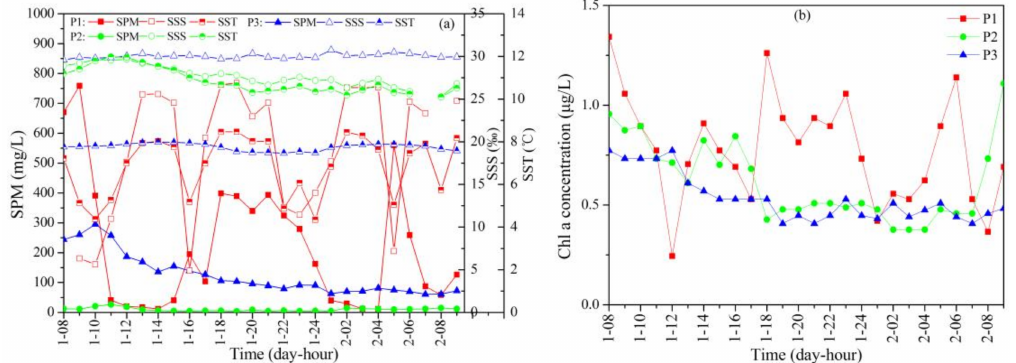
Figure 2. Hourly variations at Stations P1 (red squares, N = 26), P2 (green circles, N = 26) and P3 (blue triangles, N = 26) of: SPM, SSS, and SST ( a ); and Chl-a ( b ). The variation of SSS is consistent with that of SST which can be used as an indicator of the Yellow River discharge. The change tendency of SPM for Station P1 is opposite to that of SSS except for the time from 16 to 21, which is not obvious for Station P2 and P3.